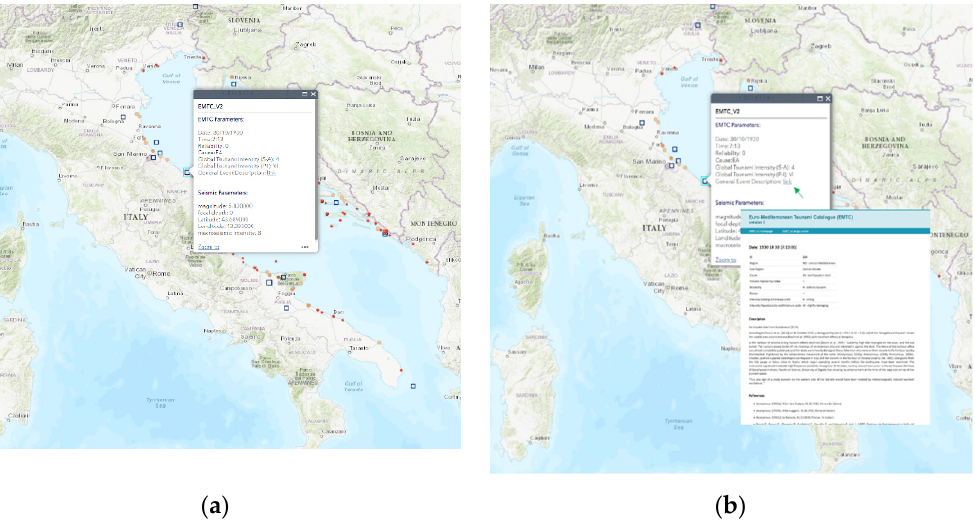
Figure 3. ( a ) Example of pop-up of the ATS layer, showing the main parameters of the 30 October 1930 Ancona tsunami. ( b ) Example of the 30 October 1930 Ancona tsunami, where the green arrow indicates the link to click on for the general description of the event.